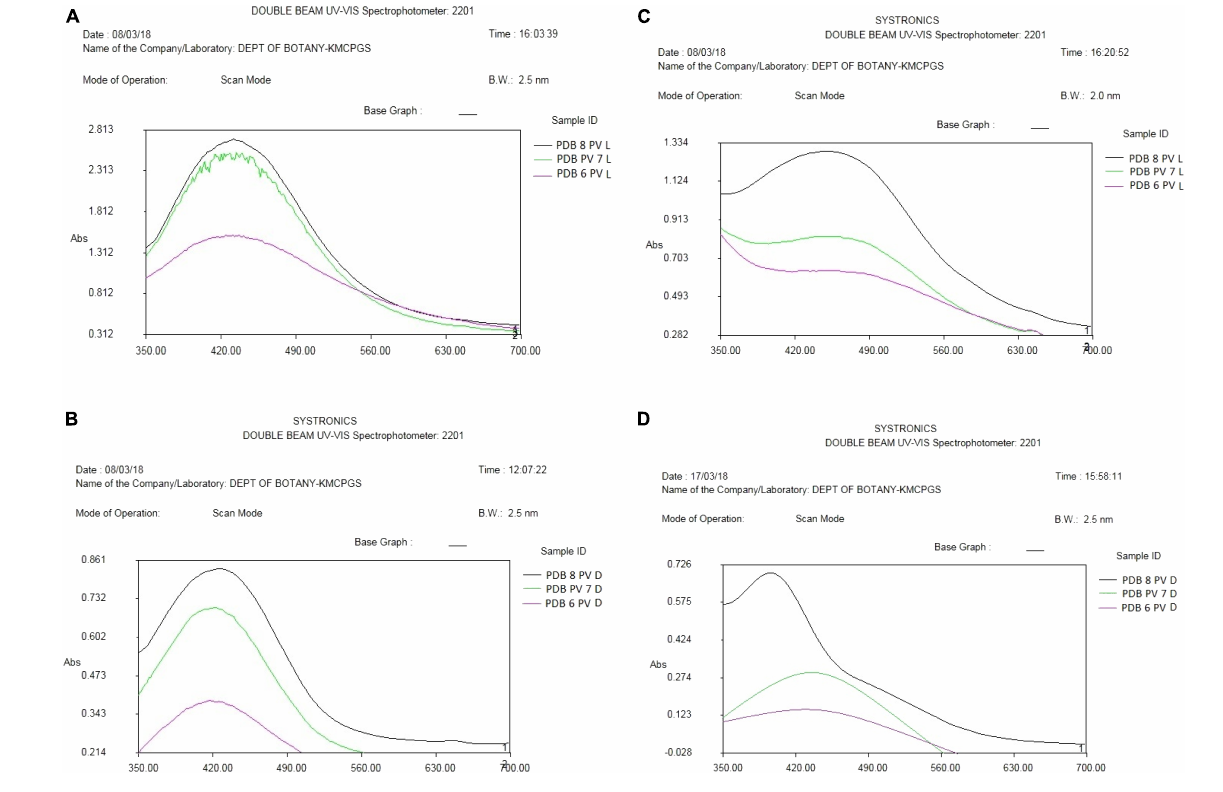
FIGURE 4 | (A) UV-Vis (visible) spectroscopy of AgNP reaction mixture 1 of P. variotii light exposed. (B) UV-Vis spectroscopy of AgNP reaction mixture 1 of P. variotii dark sample. (C) UV-visible spectroscopy of AgNP reaction mixture 2 of P. variotii light exposed. (D) UV-visible spectroscopy of AgNP reaction mixture 2 of P. variotii dark-kept